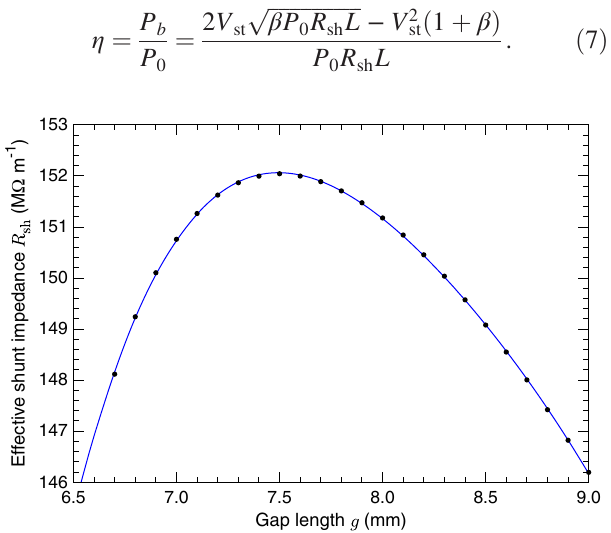
FIG. 7. Accelerating cavity of the SCS. β velocity normalized to the speed of light c ; other parameters are given in Table